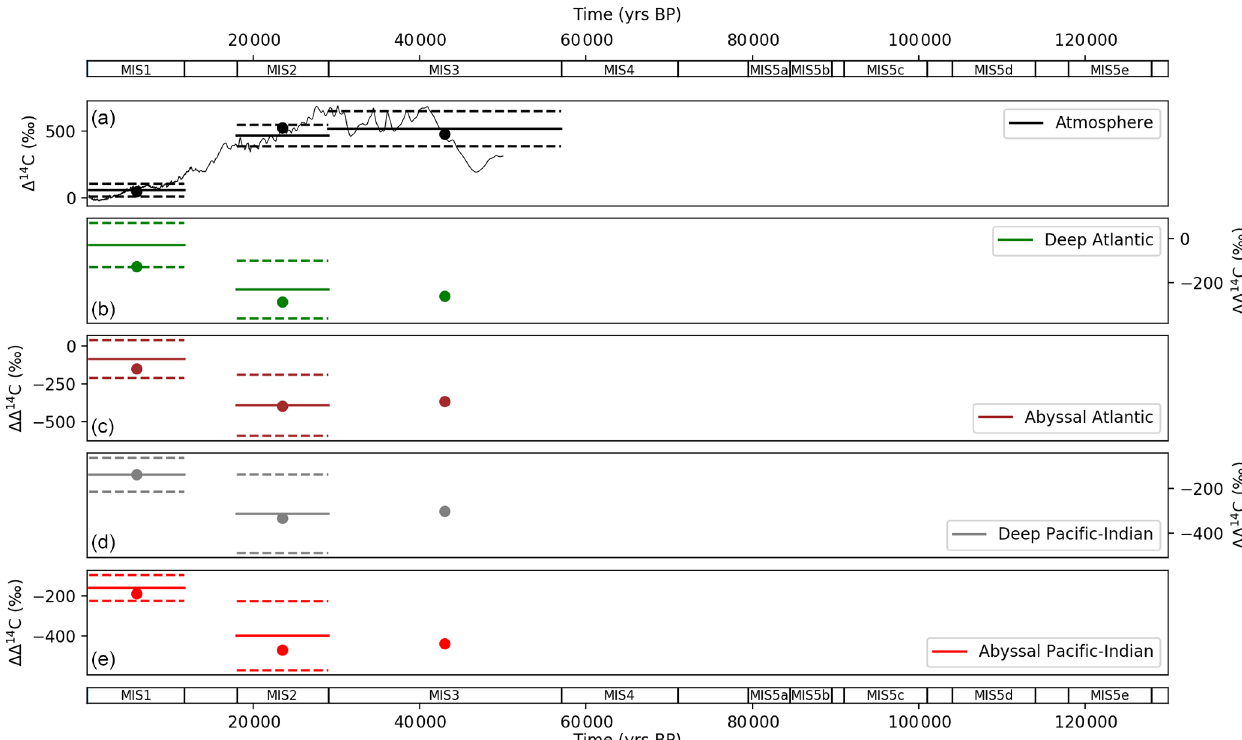
Figure 11. Values returned from the model–data experiment for (a) atmospheric (cid:49) 14 C and (cid:49)(cid:49) 14 C for (b) deep Atlantic (2500m average depth), (c) abyssal Atlantic (3700m average depth), (d) deep Pacific–Indian (2500m average depth) and (e) abyssal Pacific–Indian (4000m average depth). (cid:49)(cid:49) 14 C is ocean minus atmospheric (cid:49) 14 C, calculated to correct for the varying atmospheric (cid:49) 14 C signal. Model–data experiment results are shown as dots, with proxy data mean (solid lines) and 1 standard deviation (dashed lines) in each MIS. Model–data experiment results prior to MIS 4 are omitted, due to the radioactive decay of 14 C, which precludes natural observations prior to ∼ 50ka. Model results for each box in each MIS are shown in Tables S10 and